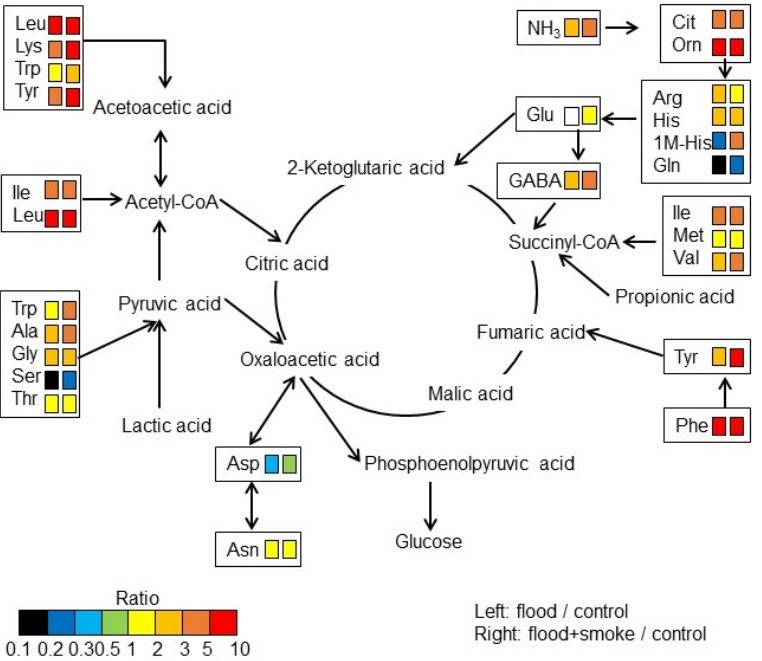
Figure 9. A mapping of altered amino acids to amino-acid metabolism in wheat treated with the plant-derived smoke solution under flooding stress. Totally, 32 amino acids identified using an automatic amino-acid analyzer were mapped onto pathways according to the KEGG database. Amino-acids analysis was performed with 3 independent biological replicates for each treatment (Table S4). The different colors indicate the different ratio ranges of the quantities of metabolites, which are calculated using the contents of wheat treated with or without the plant-derived smoke solution under flooding by those from untreated wheat. Each set of 2 boxes shows that the left is “flood/control” and the right is “flood + smoke/control”. Abbreviations: GABA, gamma-aminobutyric acid.